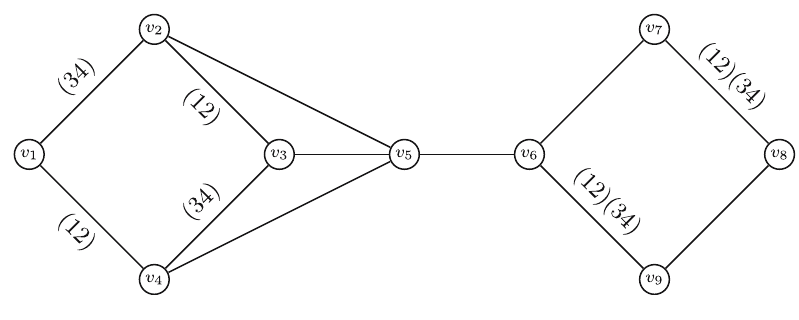
Figure 5: The S 4 - gain graph ψ Γ, ′ ( ) of Example